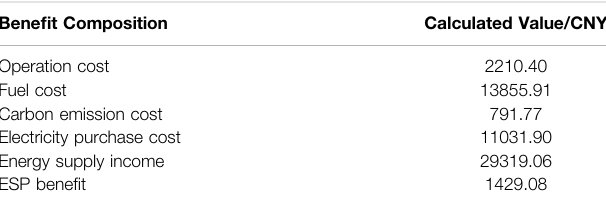
TABLE 8 | Optimal results of the ESP.